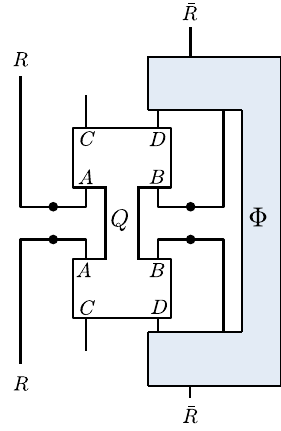
FIG. 3. Schematic representation of the decoding protocol as ¯ R the distillation of an EPR pair on R . The initial state is j EPR i RA j EPR i BB 0 . The quantum channel Q describes the time evolution of the system and Φ represents an arbitrary decoding operation acting only on B 0 D